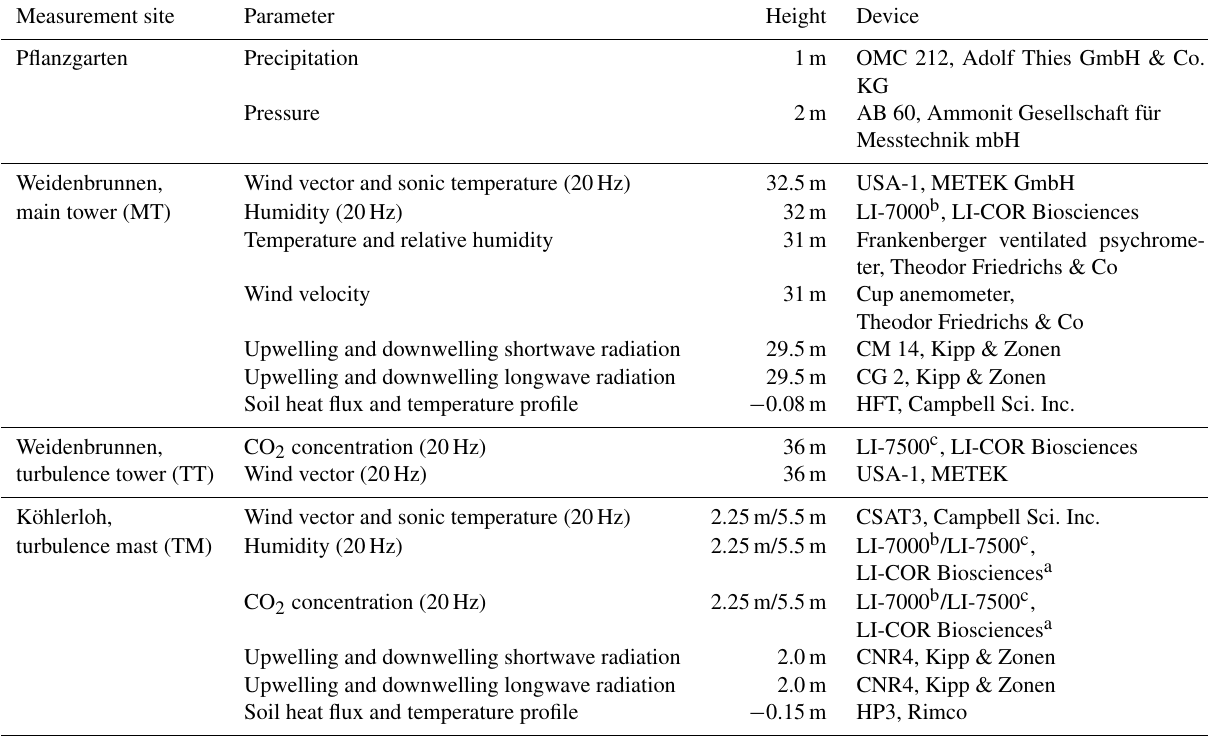
Table 2. Meteorological instrumentation for the determination of the sensible and the latent heat flux as well as the net ecosystem exchange (NEE) for forest and clearing at different measurement towers in distinct heights, using the eddy covariance technique (with the frequency of 20Hz applied as indicated), and additionally, the most important input parameter of the model (for this purpose the mean CO 2 concentrations have been averaged from the turbulence data). Documentation of the complete data set is available in Foken (2017a). Measurement